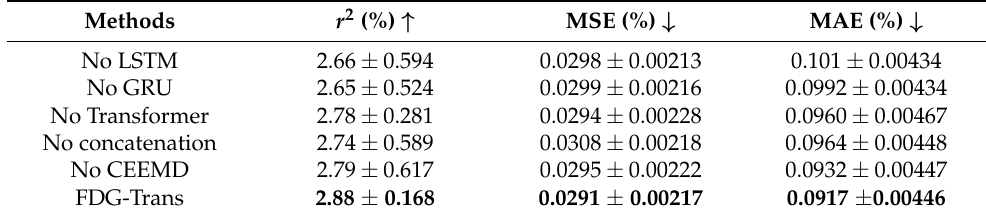
Table 4. Performances of FDG-Trans with ablation experiments.